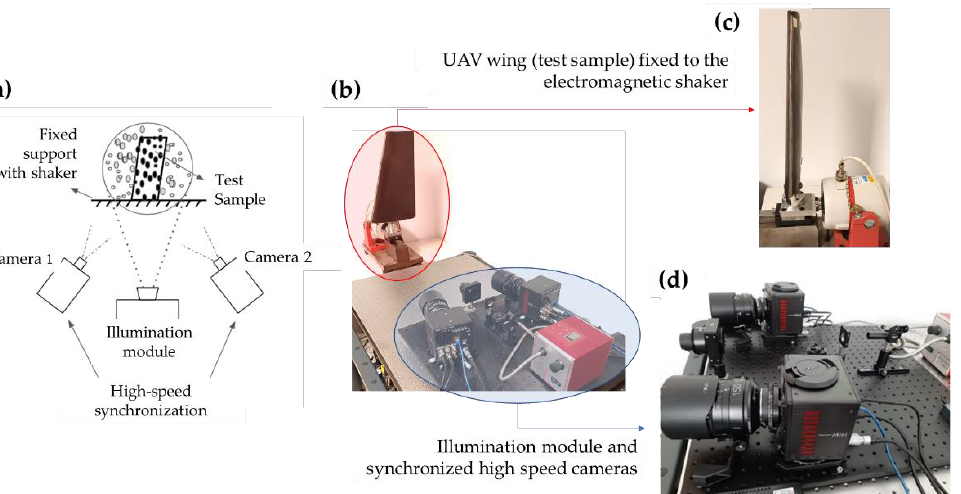
Figure 1. Experimental custom 3D-DIC set-up based on speckle pattern projection for full-field vi- bration measurements: ( a ) schematic layout of the experimental set-up and testing conditions (UAV wing made of composite material (test sample) clamped to the shaker); ( b ) set-up employed in the vibration test; ( c ) image of the UAV wing fixed to the electromagnetic shaker (lateral excitation); ( d ) optical channel for speckle pattern projection and high-speed sensors (distance of the tested sample during the measurements: 3.75 m; instantaneous field of view of the sensor: 0.5 mm).